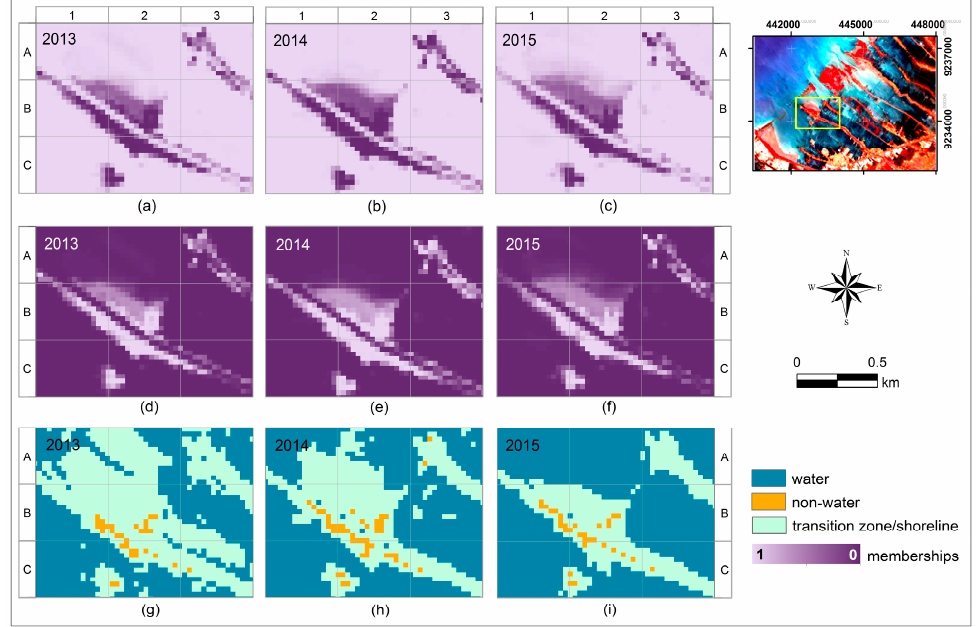
Figure 3. FCM results show the membership of: water ( a – c ); and non-water ( d – f ). To derive shoreline position, we combined both membership images using fuzzy-crisp object model ( g – i ). Blue pixels indicate core of water , orange pixels represent the core of non-water and shoreline is represented by light green pixels.